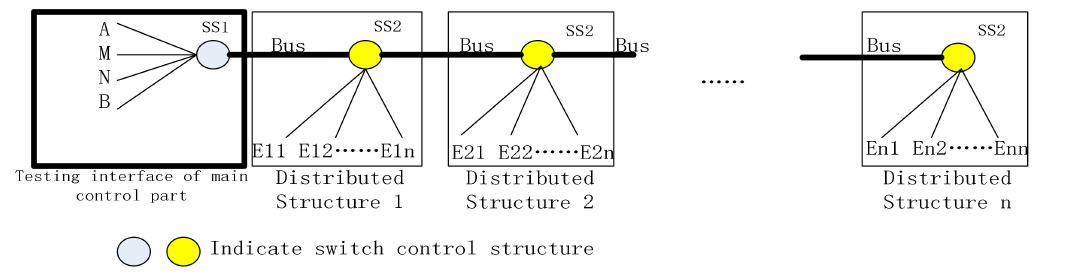
Figure 1. Structure of ESD for the distributed ERT system.